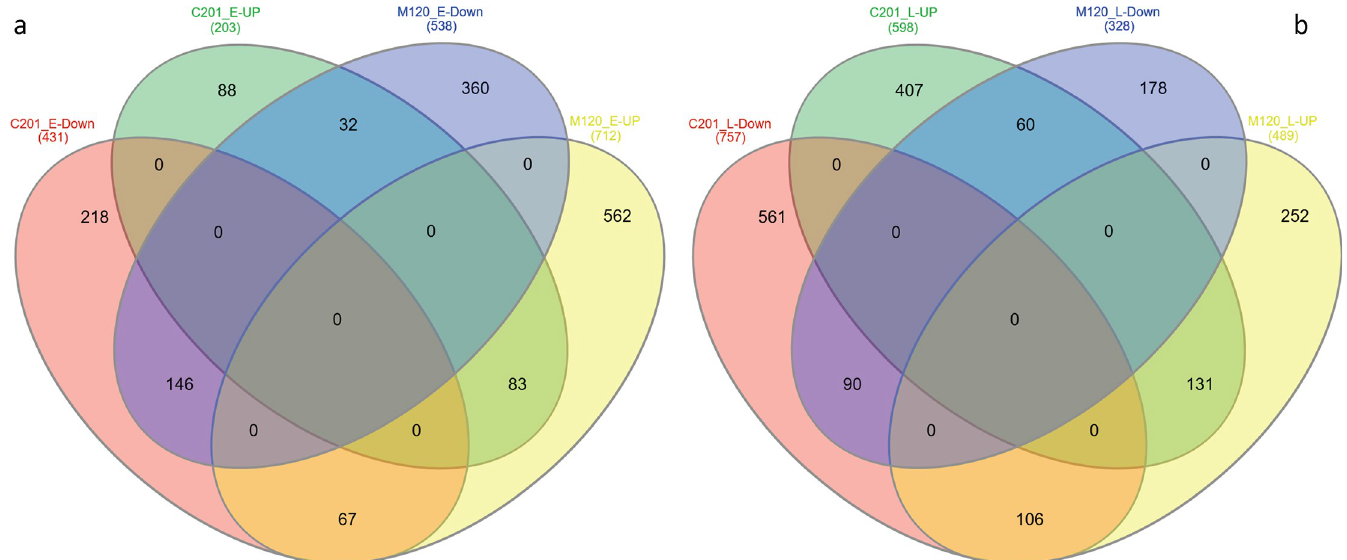
Fig 2. Venn diagram illustrating differentially expressed genes in C201 and M120 at (a) early (b) late stage of RKN infection.